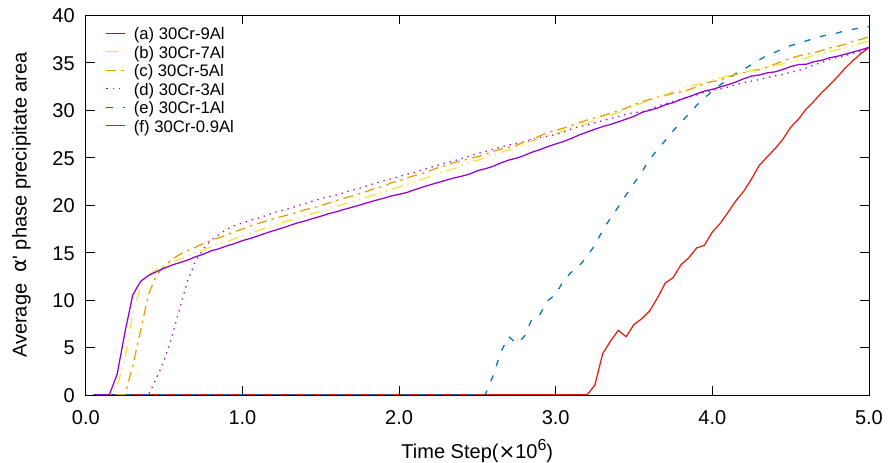
Figure 1. Average α (cid:48) precipitate area of the 2D simulation at an average Cr concentration of 30% when the average Al concentration was ( a ) 9%, ( b ) 7%, ( c ) 5%, ( d ) 3%, ( e ) 1%, and ( f ) 0.9%.